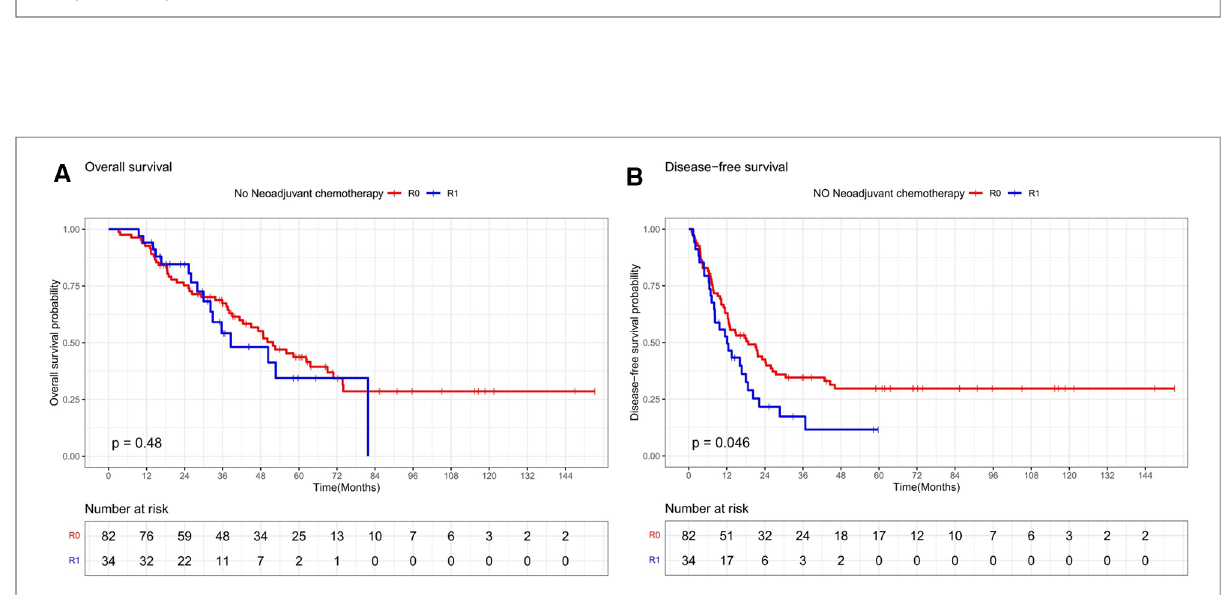
FIGURE 2 ( A ) Overall survival curves of R0 and R1 in CRLM patients (R0 ≥ 1 mm, R1<1 mm). ( B ) Disease-free survival curves of R0 and R1 in CRLM patients (R0 ≥ 1 mm, R1<1